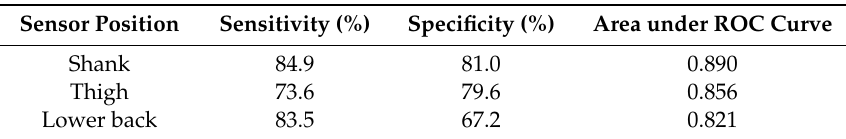
Table 2. Sensitivity, specificity, and area under ROC curve across all the subjects for the different sensor positions with the time window size 4 s and the update time 0.5 s.